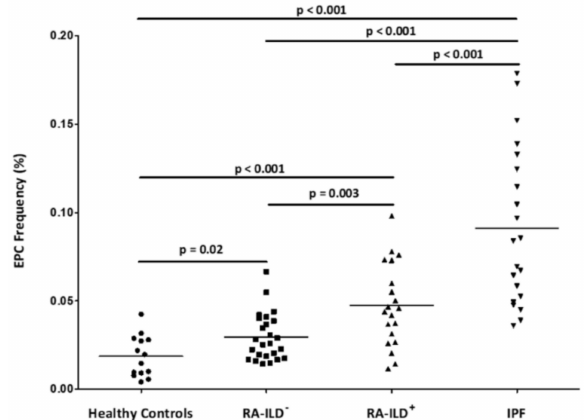
Figure 1. Quantification of EPC population by flow cytometry in all individuals included in the study. EPC were considered as CD34 + , CD45 low , CD309 + and CD133 + cells in the lymphocyte gate and were expressed as the percentage of cells in this gate. Di ff erences between the study groups were evaluated by Student’s t-test. Horizontal bars indicate the mean value of each study group. p: p- value; EPC: endothelial progenitor cells; RA: rheumatoid arthritis; ILD: interstitial lung disease; IPF: idiopathic pulmonary